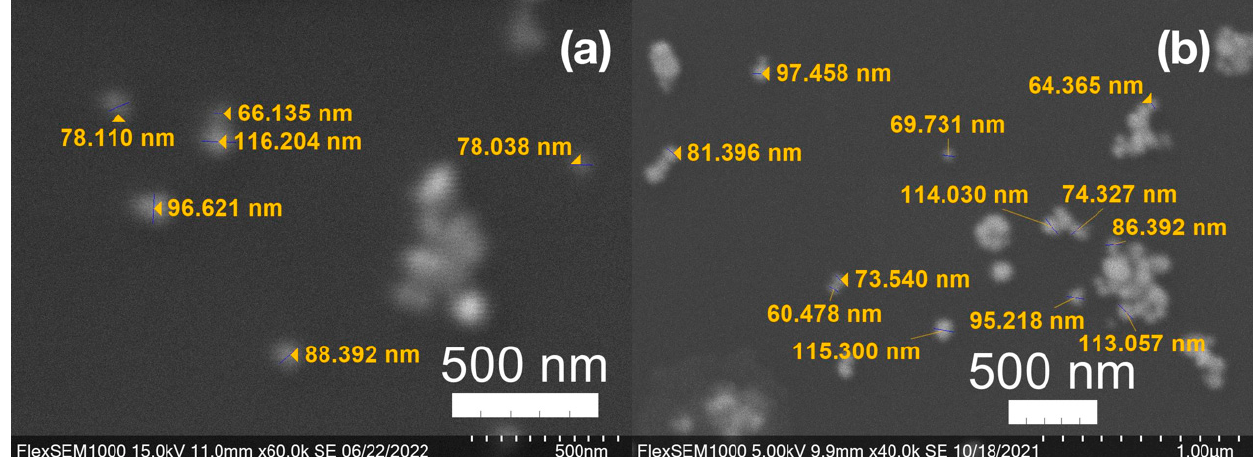
Figure 7. ( a ) Gold (Au) and ( b ) silver (Ag) nanoparticles synthesized with medium roast coffee grounds (SCGs) from French press brew (SMH).